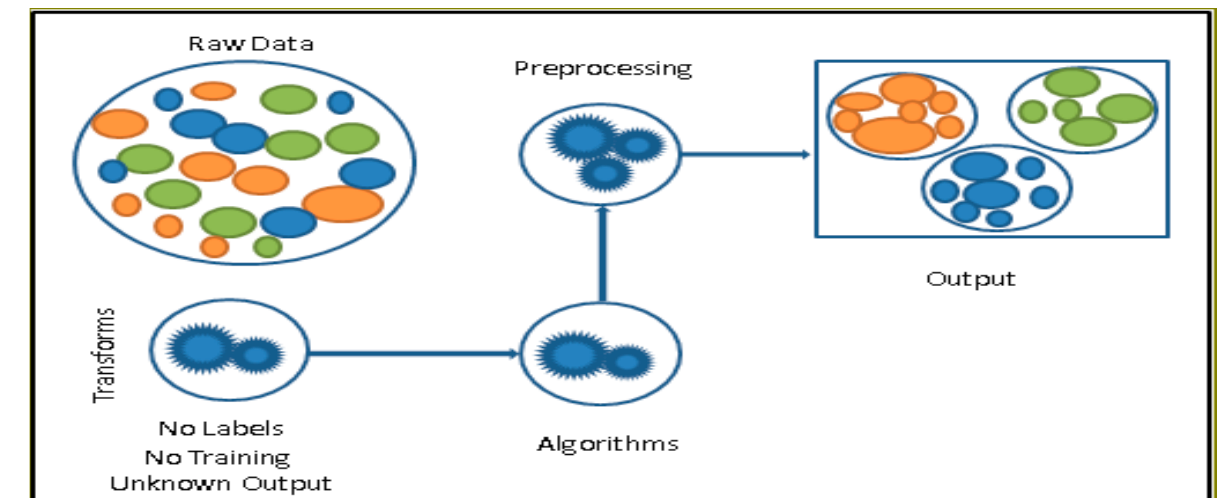
Figure 6. Unsupervised anomaly